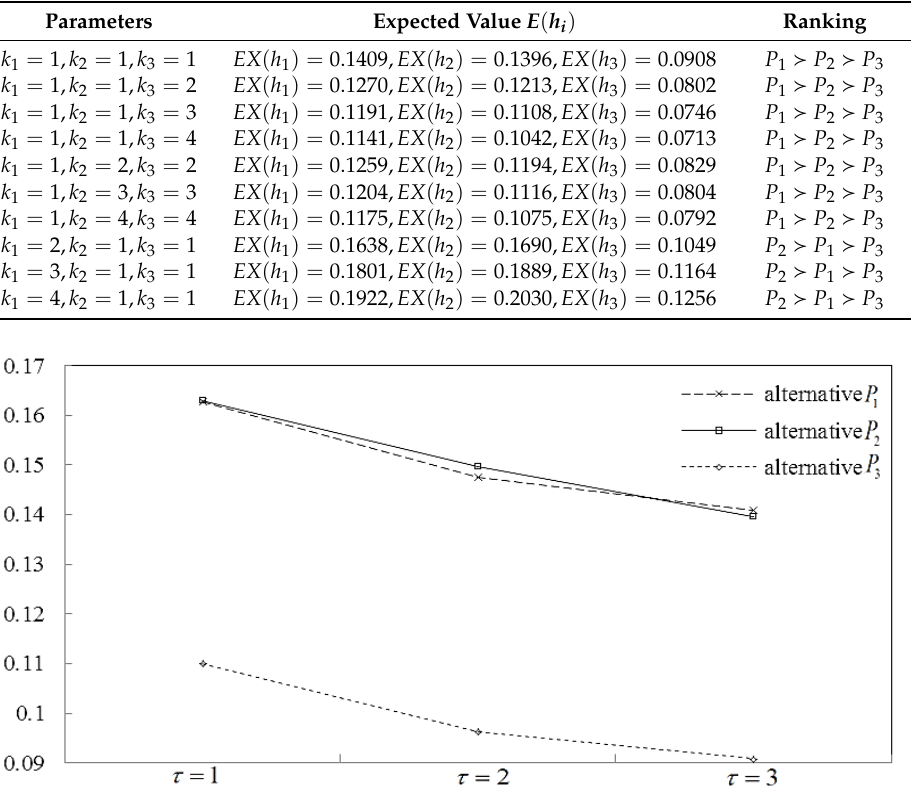
Figure 1. Expected values of the alternatives with di ff erent parameter τ . Table 5. Ranking results with different parameters 1 2 , k k .